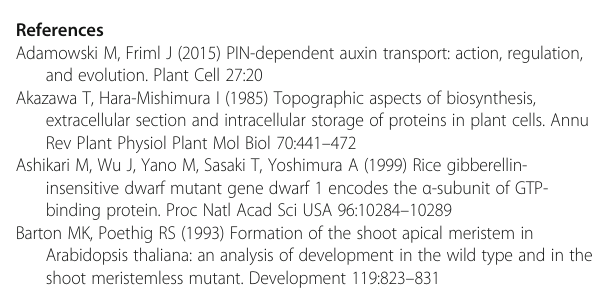
Additional file 1: Figure S1. Pollen viability and embryo structures in the RGB1/rgb1 heterozygous mutant lines. (a) Pollen viability in the WT and RGB1/rgb1 heterozygous mutants (Bar= 200 μ m). The pollen grains were stained with 1% I 2 – KI and imaged with a Leica DM 1000 light microscope. (b) Median longitudinal sections of WT and RGB1/rgb1 heterozygous mutant seeds (18days after flowering); a plumule, b radicle. Additional file 2: Figure S2. Phenotypes and genotypes of the rgb1 mutants; relative expression of G protein genes in the embryos of the WT and rgb1 mutants. (a-d) DNA sequences and phenotypes of the WT and rgb1 mutants. (a) WT, (b) rgb1 – 1 , (c) rgb1 – 2 , (d) rgb1 – 3 . Mutations are shown in red. (e) Relative expression of RGB1 in the embryos of the WT and the rgb1 – 1 and rgb1 – 2 mutant lines, as determined by qRT-PCR. The forward primer used in the qRT-PCR assays was the RGB1-Cas9 target sequence. (f-h) Relative expression of G protein family genes in the embryos of the WT and the rgb1 – 1 and rgb1 – 2 mutant lines from (f) 1- day-old seedlings, (g) 2-day-old seedlings, and (h) 3-day-old seedlings. (DOCX 2619 kb) Additional file 3: Figure S3. Induction of RGB1 expression by NAA and measurements of the concentrations of endogenous hormones in the rgb1 mutant and WT. (a) Relative expression of RGB1 in 7-day-old wild- type seedlings grown in mock medium and in medium supplemented with 10 μ M NAA. (b-f) Mass spectrometric measurements of different endogenous hormones in the embryos of 3-day-old seedlings. (b) IAA, (c) BRs, (d) IPA, (e) ABA, (f) GA 3 . (DOCX 2663 kb) Additional file 4: Figure S4. Stages of seed germination and early postgermination seedlings of rice. (DOCX 4775 kb) Additional file 5: Figure S5. Comparison of gene expression determined by qRT-PCR and RNA-seq and relative expression of auxin signaling-related genes in the embryos of the WT and rgb1 – 2 mutants at 2 and 3days after germination. (a) Comparison of relative gene expression levels determined by RNA-seq and qRT-PCR. Pearson ’ s test indicated a strong correlation between the two techniques (r=0.85; p <0.05). (b-d) Relative expression of auxin-related family genes. Gene expression was de- termined in the WT and rgb1 – 2 mutant embryos at 2 and 3days after ger- mination. (b) OsIAA ; (c) OsARF ; (d) OsPIN (DOCX 476 kb) Additional file 6: Table S1. Oligonucleotide primers and probe sequences used. (DOC 113 kb) Additional file 7: Table S2. Genotypes of the seeds in the T0-, T1-, and T2-generation transgenic seedlings. (XLSX 16 kb)